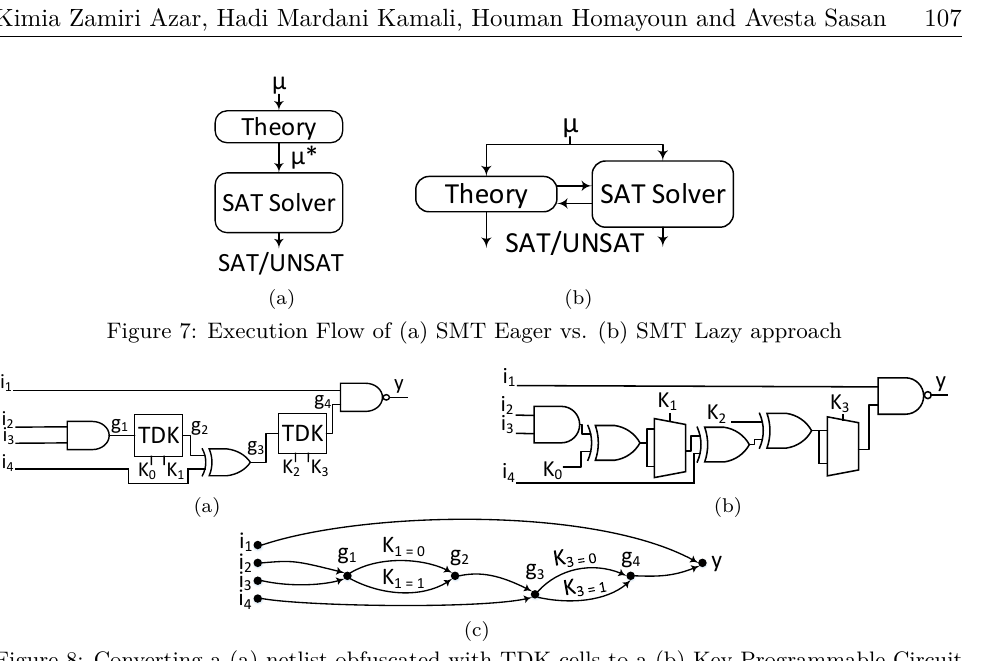
extend its capabilities to attack obfuscation schemes that could not be logically